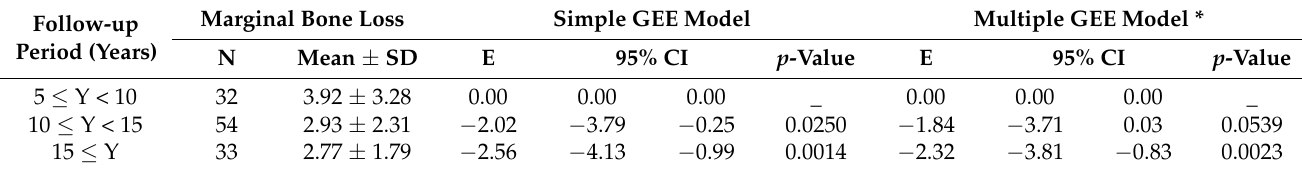
Table 7. Comparison of marginal bone loss based on follow-up period